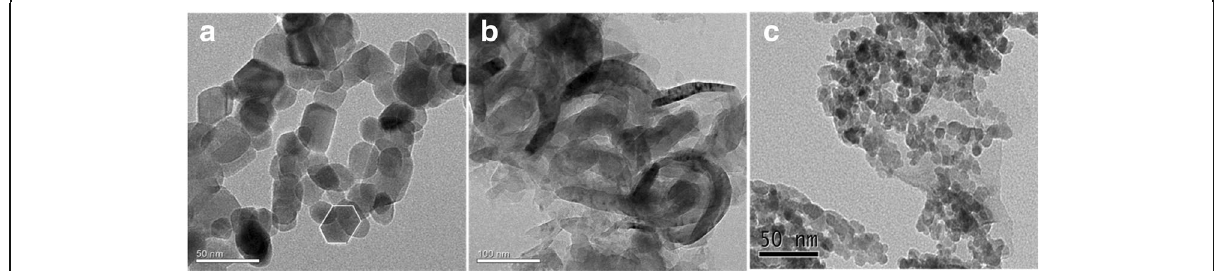
Fig. 2 TEM images of a ZnO, b g-C 3 N 4 , and c ZnO/Fe 3 O 4 /g-C 3 N 4